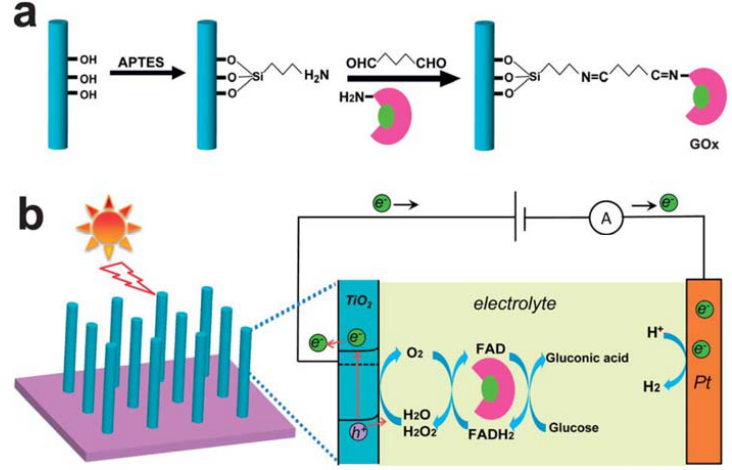
Figure 9. ( a ) Schematic of glucose oxidase (GOx) functionalization on the TiO 2 nanowire surface via silane/glutaraldehyde linkage chemistry. APTES: 3-aminopropyl triethoxysilane. The green and pink colors of GOx indicate the flavin group (FAD) redox center and the external insulating protein shell, respectively. ( b ) Schematic of the TiO 2 –GOx NW-based PEC sensor for glucose detection. Under sunlight illumination, the photogenerated holes oxidize H 2 O or H 2 O 2 over the TiO 2 NW anode to form O 2 , which serves as an efficient electron acceptor of FAD/FADH2. Glucose is oxidized to gluconic acid during this cycle. On the cathode (Pt), the photogenerated electrons reduce water to form H 2 . The current flowing through the circuit is recorded as the sensing signal. Reprinted with permission from ref. [73]. 2013 The Royal Society of Chemistry.